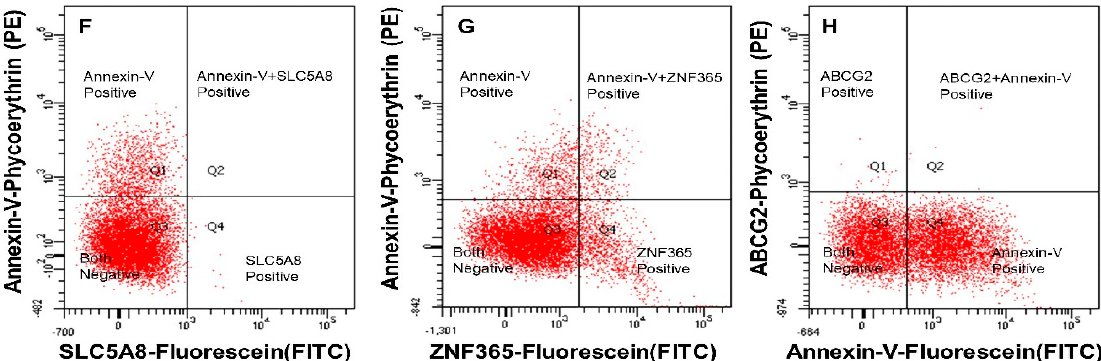
Figure 2. Representative scatter plots and fluorescence dot plots from the FACSCanto™ flow cytometer. ( A ) Example scatter plot of buffer with fluorophore-conjugated antibodies and calibration beads (no samples). ( B ) Example scatter plot of diluted urine plus appropriate fluorophore-conjugated antibodies and calibration beads. ( C – H ) Fluorescent dot plot (quadrants derived from microvesicle gate (contain major portions of extracellular vesicles) of ( B )) showing fluorophore spectra for Annexin-V and SLC2A9 antibodies ( C ), SLC17A3 antibodies ( D ), URAT1 antibodies ( E ), ZNF365 antibodies ( F ), ABCG2 antibodies ( G ), and SLC5A8 antibodies ( H ).